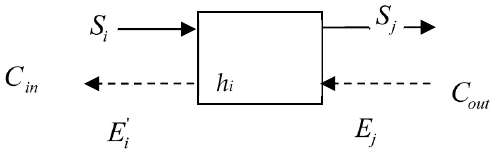
Figure 4. Outgoing Send stream is chaffed .